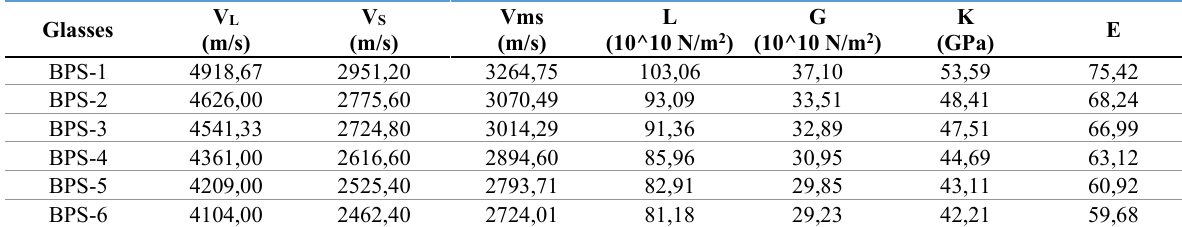
Table 2 Longitudinal Velocity (V L ), Transverse velocity (V s ), Average sound velocity (V ms ), Longitudinal Module (L), Transversal Modulus (G), Bulk Module (K) e Young's Module